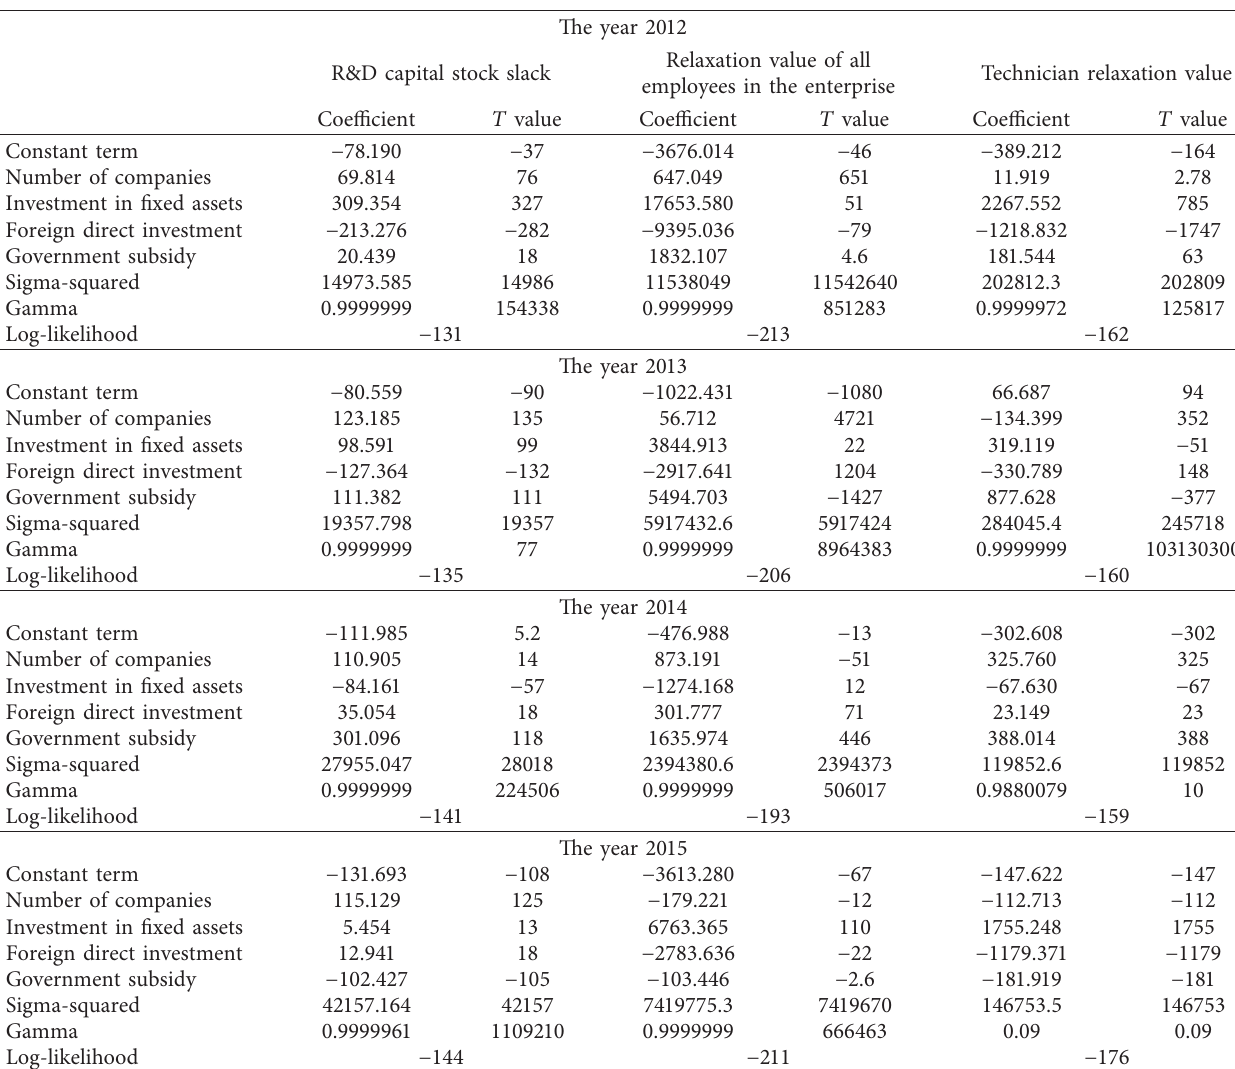
Table 4: Results of relevant parameters using the SFA model from 2012 to